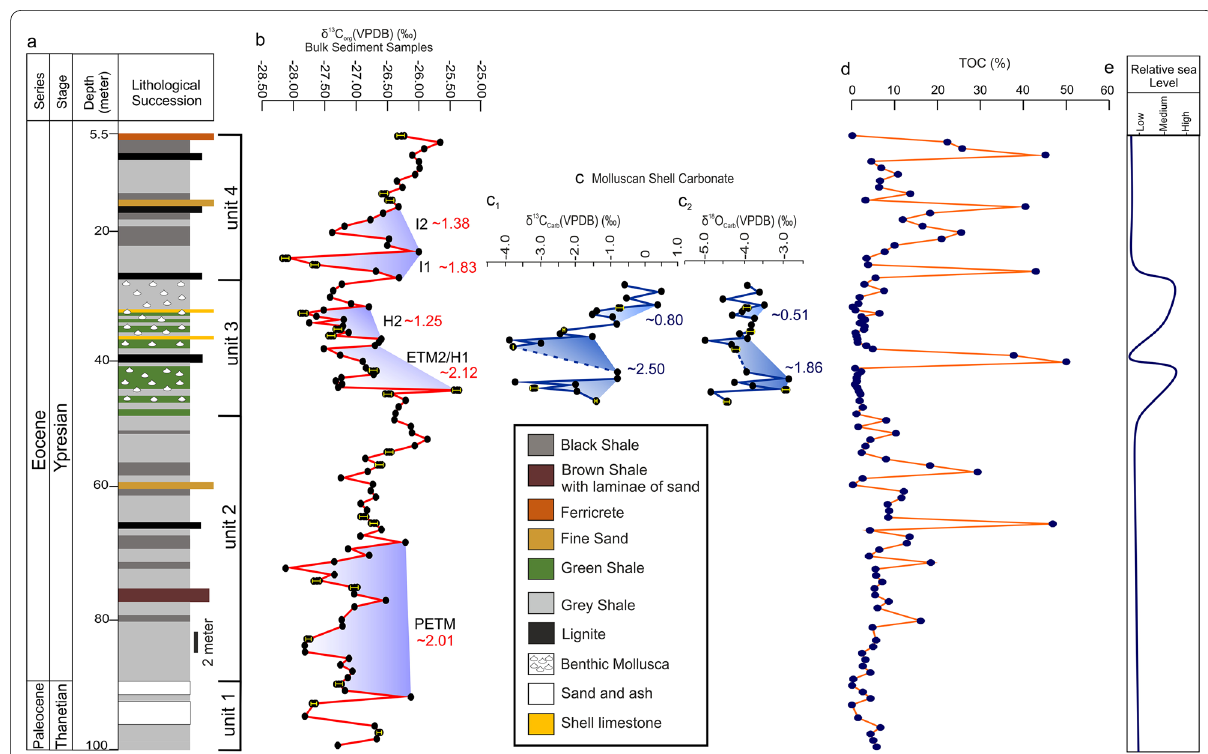
Fig. 6 a Lithostratigraphic section of Umarsar mine. b Bulk sediment organic matter δ 13 C stratigraphy; hyperthermal events are demarcated. c